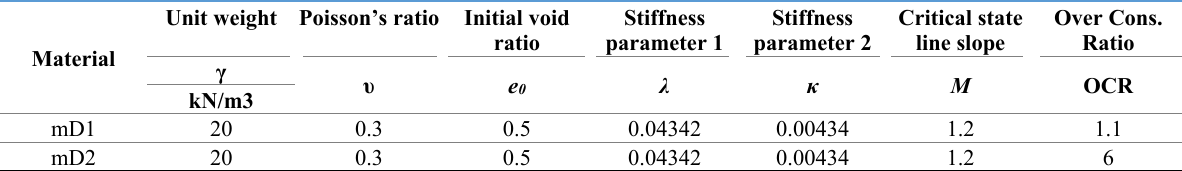
Table 2. Parameters for materials mD1 and